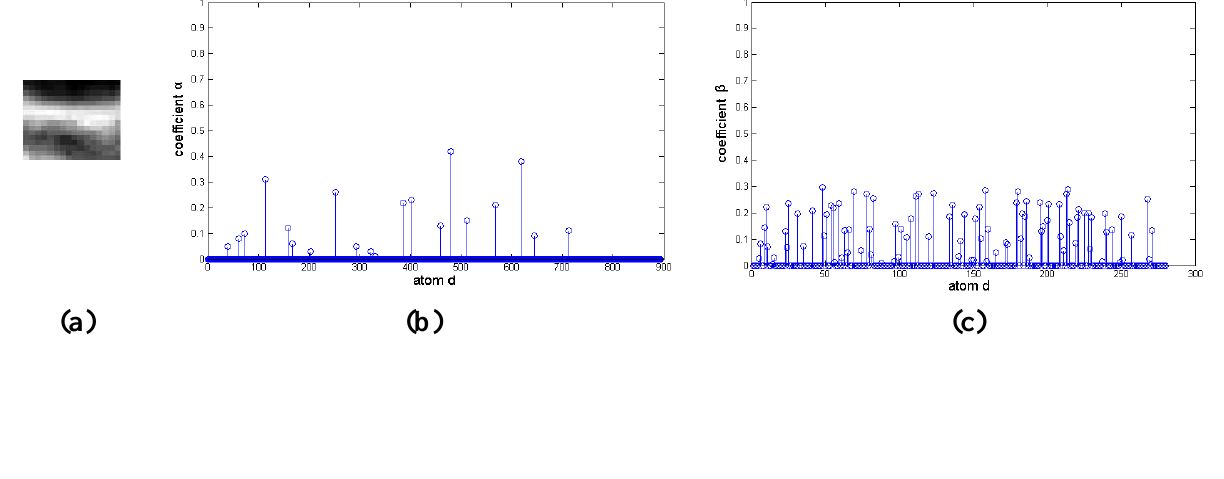
Figure 15. Representation coefficient of background block decomposed in cloud image on discriminative over-complete dictionary. ( a ) Sparse coefficient on background dictionary, ( b ) Sparse coefficient on target